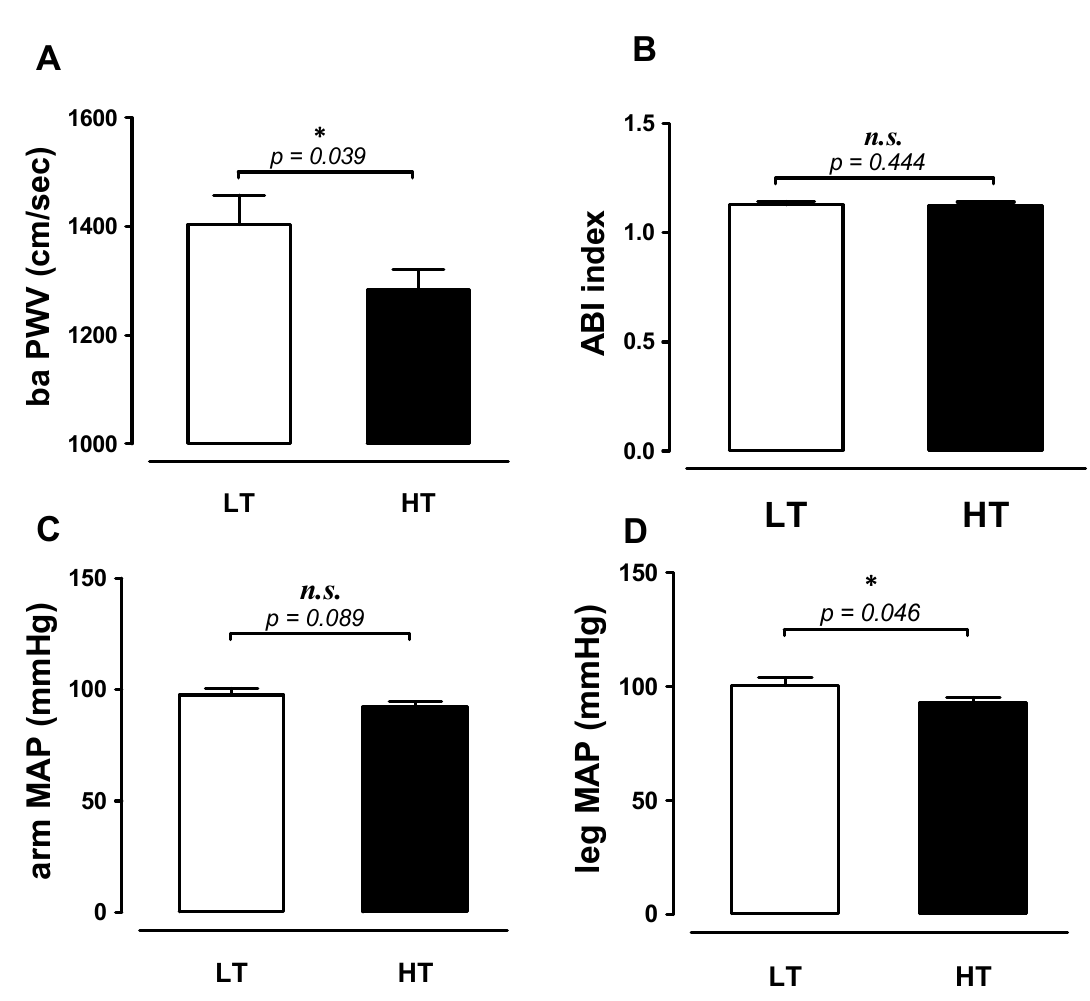
Figure 3. Differences in baPWV, ABI index, and blood pressure in LT and HT. ( A ) baPWV, ( B ) ABI index, ( C ) arm MAP and ( D ) leg MAP were measured in HT and LT groups (LT, open bar; HT, black bar). Data are expressed as Mean ± S.E.M. * denotes significant difference between two groups ( p < 0.05). Low tennis time group (LT), high tennis time group (HT), ankle-brachial index (ABI index), mean arterial blood pressure (MAP).